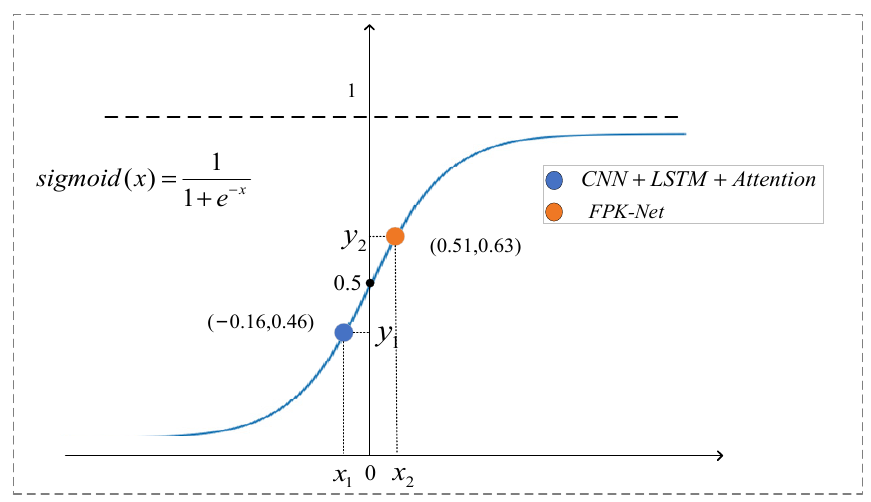
Figure 9. Schematic diagram of interpretability analysis .